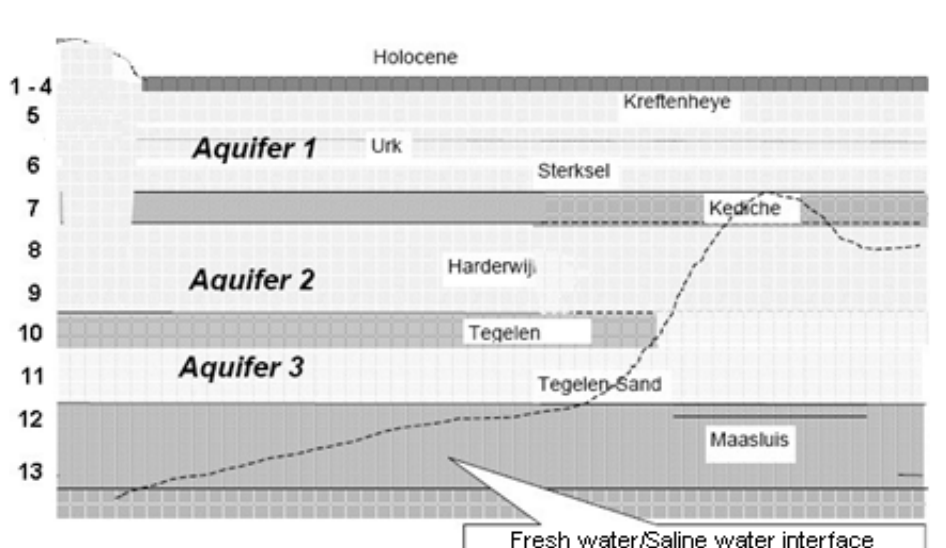
Fig. 8 Schematization of the CCL